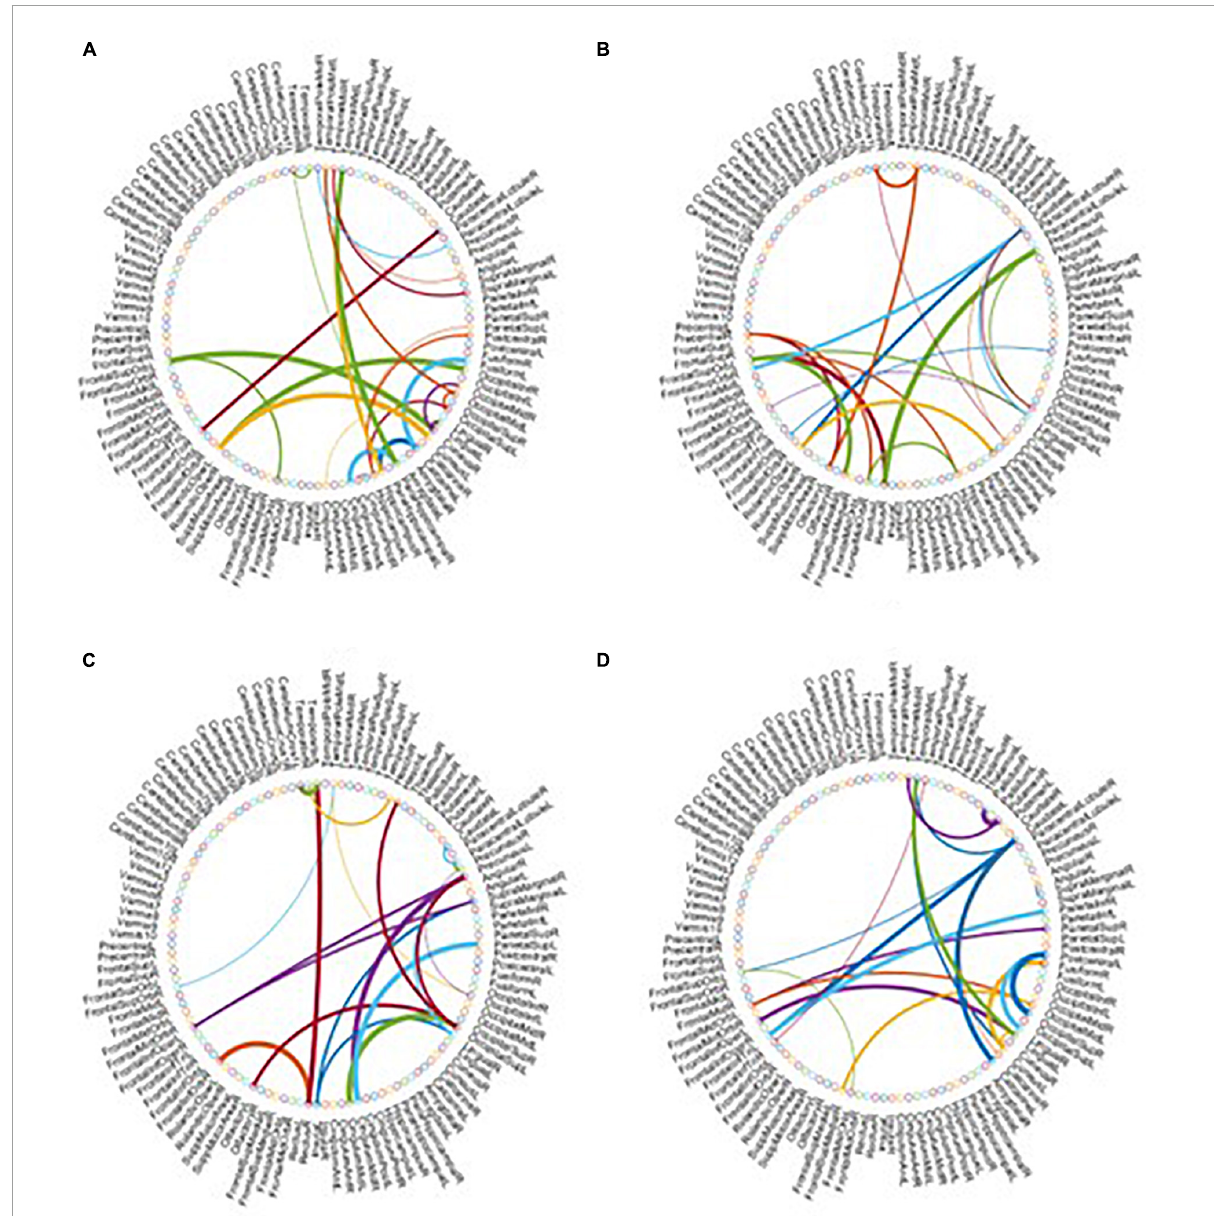
FIGURE5 Most discriminative functional connections in four classification tasks: (A) eMCI vs. NC, (B) lMCI vs. NC, (C) AD vs. NC, and (D) eMCI vs. lMCI.